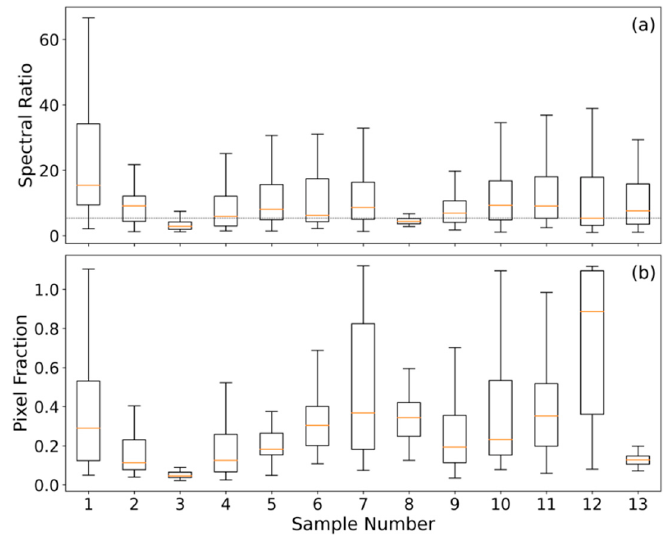
Figure 5. Results of the investigation as to the nature of the thirteen matchup peatland fires focused on herein and shown in Figure 2. ( a ) Boxplots of the “excess above background” 3.9 to 11 µm spectral radiance ratio for the Himawari active fire pixels making up each fire, along with that associated with a 700 K fire (5.4 W m 2 sr − 1 µm − 1 (W m 2 sr − 1 µm − 1 ) − 1 ); shown by the dashed vertical line. ( b ) Boxplots representing the fraction of each Himawari pixel that would be required to be covered by a subsurface smouldering peat fire having an effective surface temperature of 412 K (mean of the surface temperatures determined in [57]). Himawari-8 active fire pixels are those detected within the associated plume polygons shown in Figure 2 in the hour prior to the VIIRS afternoon overpass. In both ( a ) and ( b ), the boxplots follow standard conventions showing the median (red horizontal lines), interquartile range (box), and minimum and maximum values (whiskers).